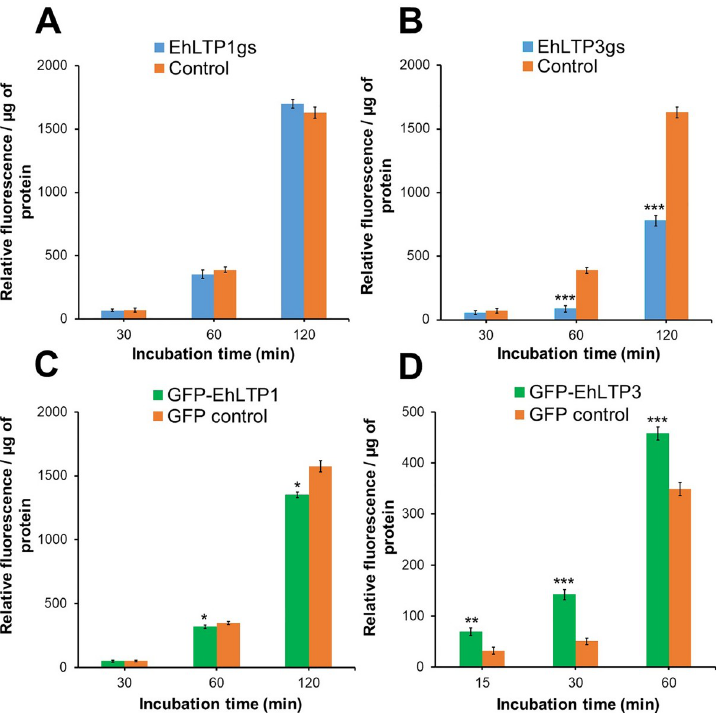
Fig 3. Effects of gene silencing of EhLTP1 (A) and EhLTP3 (B) or overexpression of EhLTP1 (C) and EhLTP3 (D) on endocytosis of the fluid-phase marker RITC dextran. E . histolytica gene silenced transformants [EhLTP1gs or EhLTP3gs, (A) or (B), respectively], overexpressing transformants [GFP-EhLTP1 or GFP-EhLTP3 in (C) or (D), respectively) and their corresponding vector control [psAP2 control (A, B) or GFP control (C, D)] cell lines were incubated with 2 mg ml -1 of the fluid-phase marker RITC dextran in BI-S-33 medium for indicated time. Cells were collected, washed, and the fluorescence of incorporated RITC-dextran was measured using a fluorometer as per the method described in Methods. The experiment was repeated three times independently in duplicates (N = 3 with error bars indicating standard deviation). Statistical comparisons were made by Student’s t-test ( � P � 0.05, �� P � 0.005, ��� P �